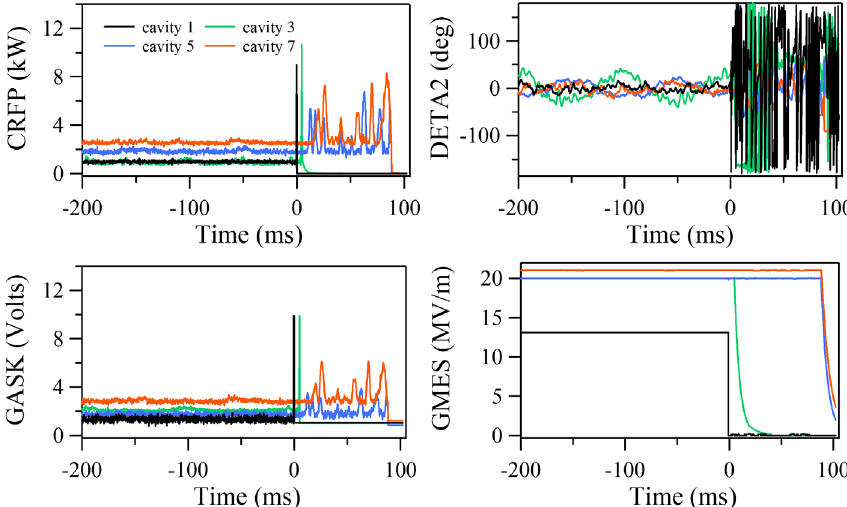
FIG. 12. Waveforms for an electronic quench. The plots display the forward power (top left), detune phase angle (top right), a digital signal proportional to the drive voltage (bottom left), and the measured gradient (bottom right). Only four of the eight cavities are plotted for clarity. Note that the scale of the horizontal axis has been modified to begin 200 ms before the fault event.